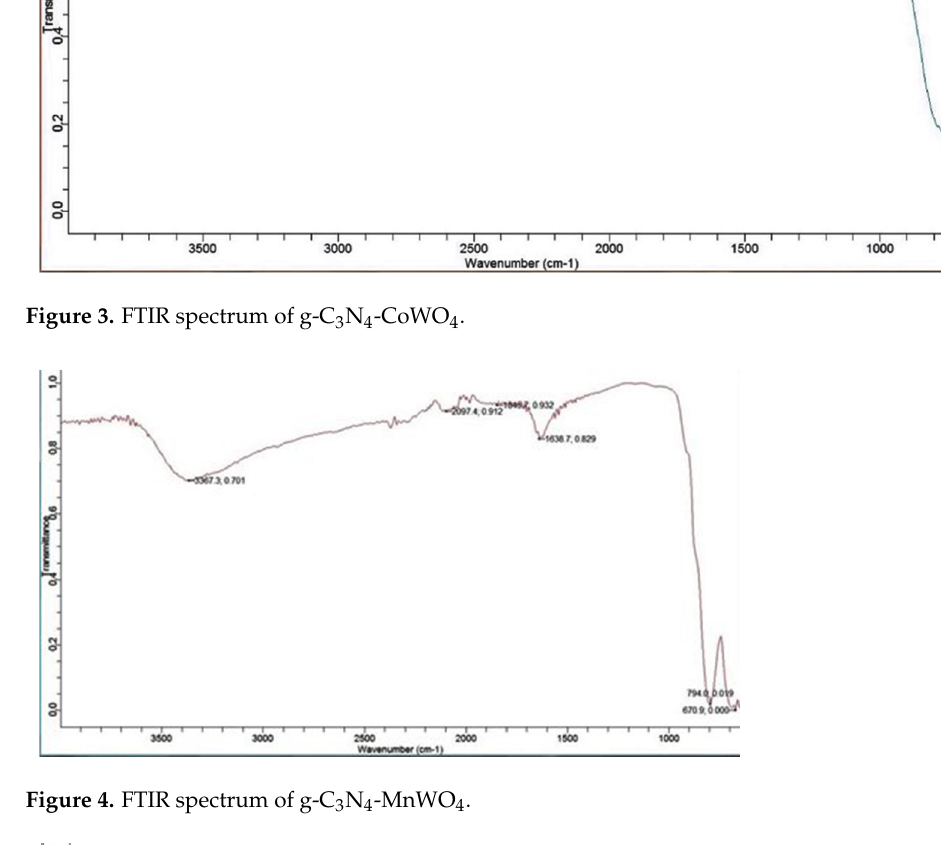
Figure 3. FTIR spectrum of g-C 3 N 4 -CoWO 4.